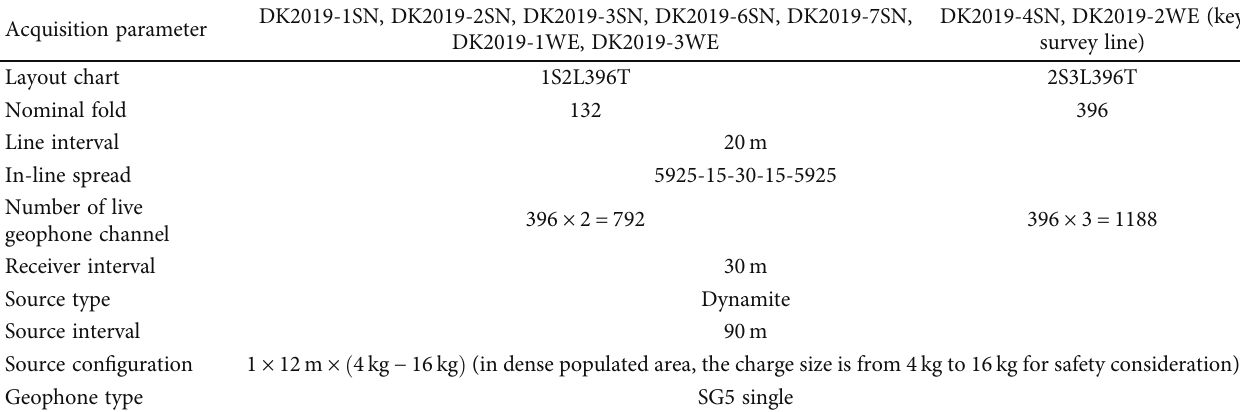
Table 4: Recording parameters for the seismic survey at Dailekh area.